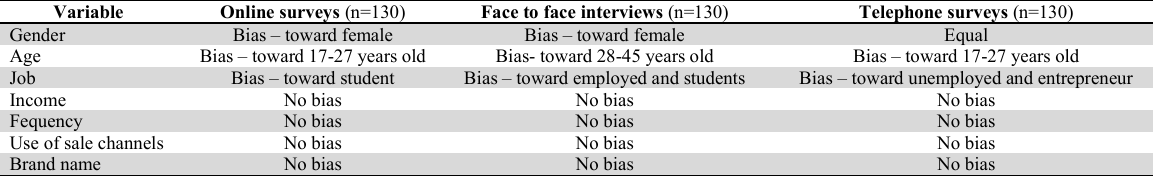
Overview of the strengths and weakness of the sampling methods